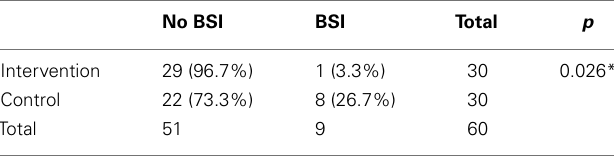
Table 2 | Culture-proven BSI occurrence in both groups .